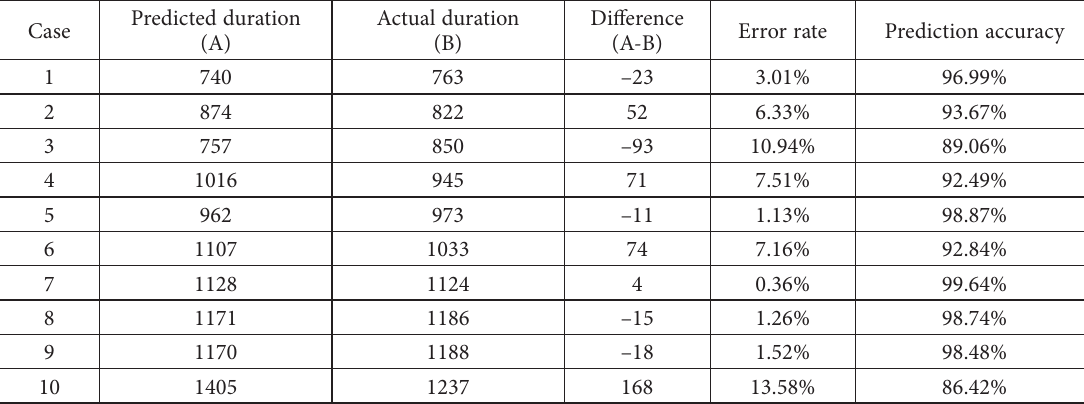
Table 14. Calculation of the predicted construction duration, error rate, and prediction accuracy